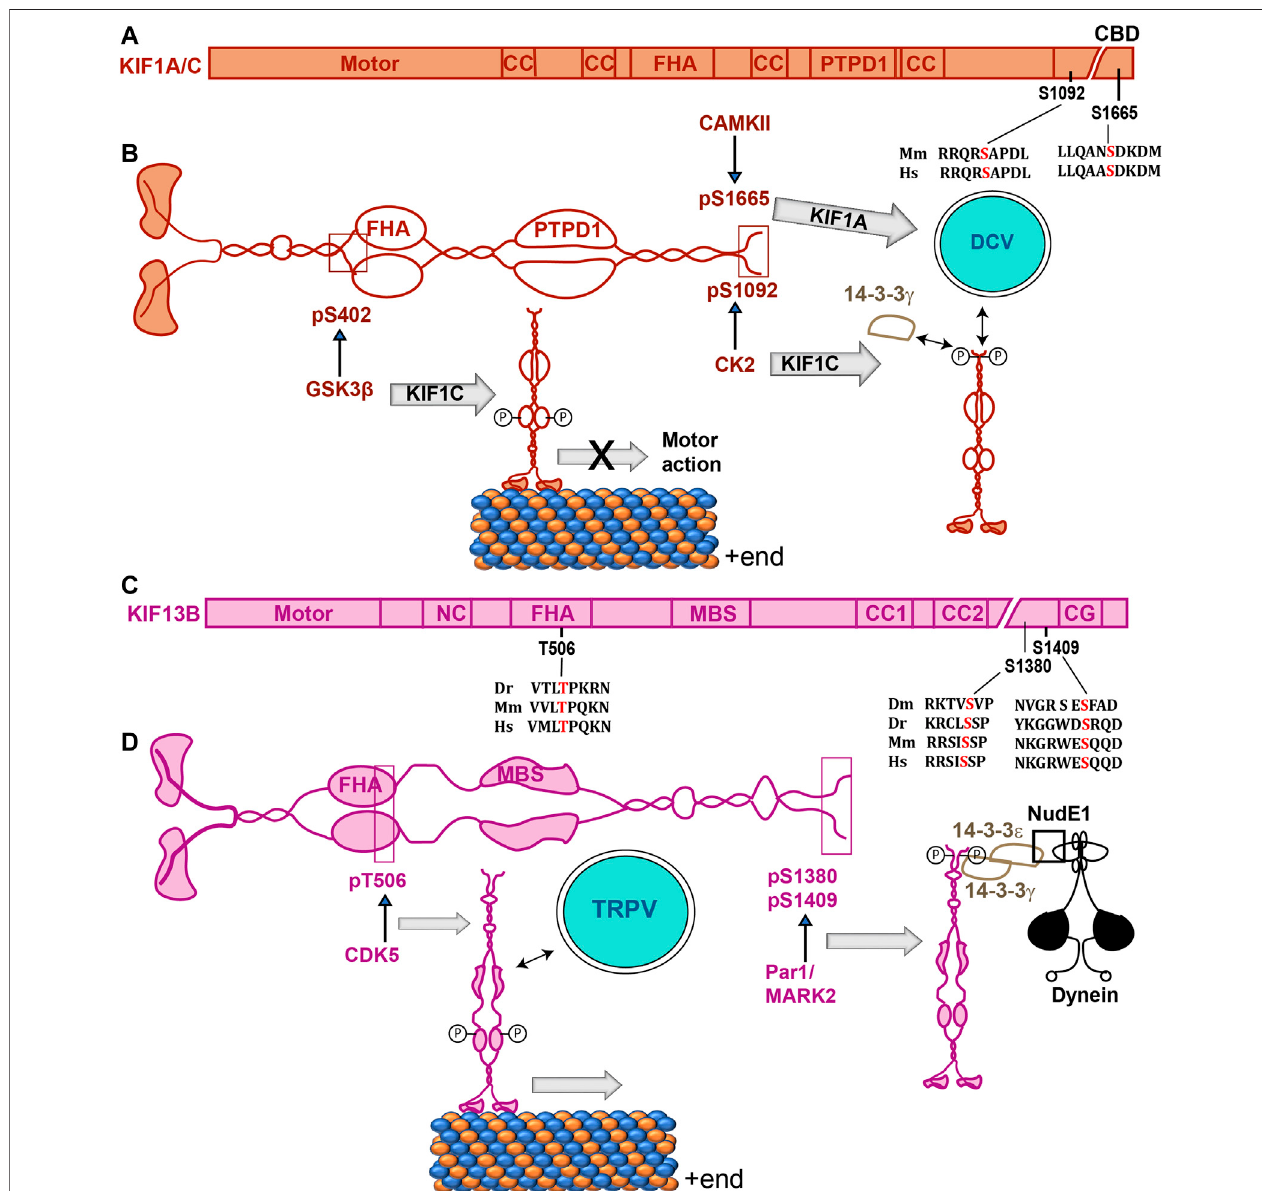
FIGURE 4 | Phosphorylation sites of Kinesin-3 isoforms and their effects on their function. (A,C) Domain organizations of mammalian Kinesin-3 subunits with relative positions of phosphorylation sites and alignments of the surrounding amino acid sequences from different species are indicated on the primary structures. Dm, Dr, Mm and Hs represent Drosophila , zebra fi sh, mice, and humans. (B,D) Schematics indicate the structure of Kinesin-3 family proteins Kif1A/C (B) and Kif13B (C) , respectively, and illustrate the effects of phosphorylation of different serine residues. CaMKII-dependent phosphorylation of Kif1A increased its association with DCV, and CK2-dependent phosphorylation of Kif1C promoted association with 14-3-3 γ (B) . In the case of Kif13B, FHA domain phosphorylation by CDK5 enhanced association with the vesicles carrying TRPV receptors, and MARK2/Par1-dependent phosphorylation in the tail domain promoted association with the dynein motor complex through 14-3-3 γ / ε heterodimer (D) . Abbreviations: CC, coiled-coil; CDK5, Cyclin-Dependent Kinase 5; CG, CAP-Gly domain; CK2, Casein Kinase 2; DCV, Dense Core Vesicle; FHA, Fork Head Associated domain; MBS, MAGUK binding domain; NC, neck coil; PTPD1, Protein Tyrosine Phosphatase D1 binding domain; TRPV, Transient Receptor Potential Vanilloid; T-, threonine; pT, Phosphothreonine.